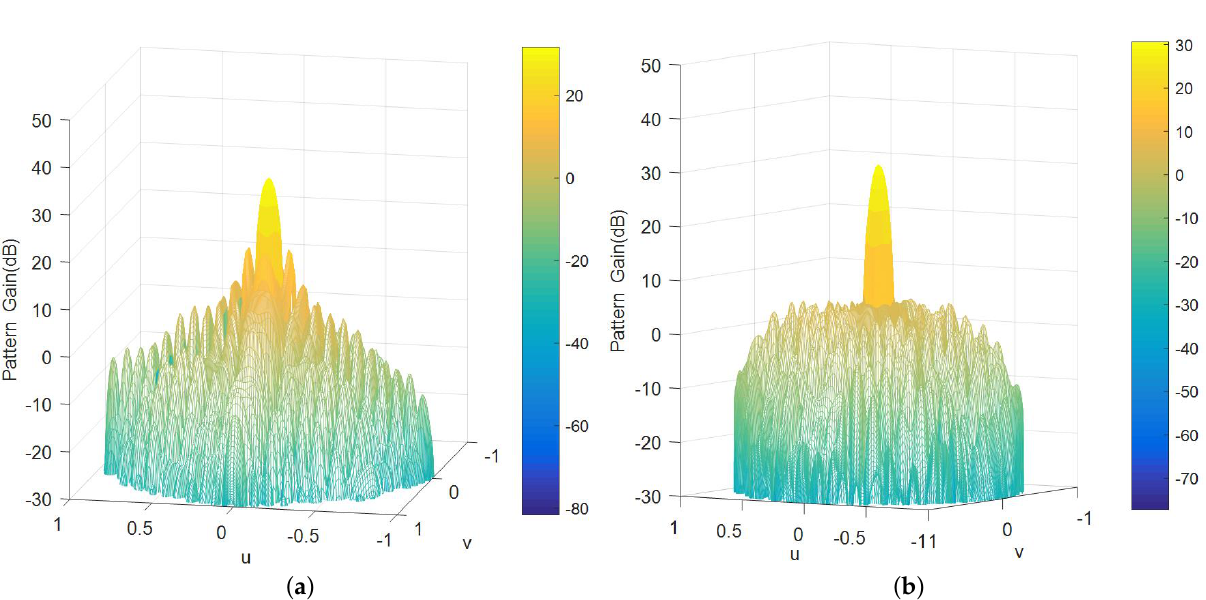
Figure 10. 3D beam patterns of 528-element Planar Phased Array. ( a ) 3D beam pattern of the uniform 528-element Planar Phased Array; ( b ) 3D beam pattern of the 528-element Planar Phased Array optimized with IMOA.